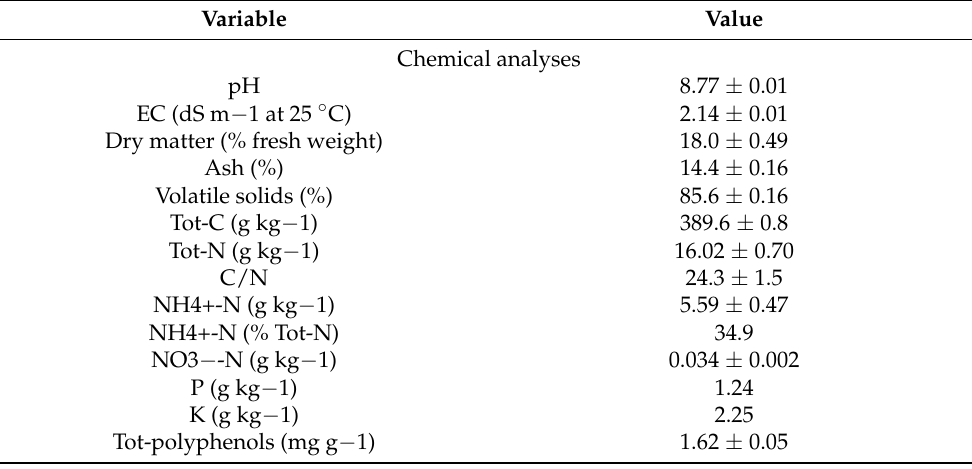
Table 1. Chemical properties of the solid fraction of the anaerobic digestate. Values are means ± SD (n = 3) expressed on a dry matter basis.